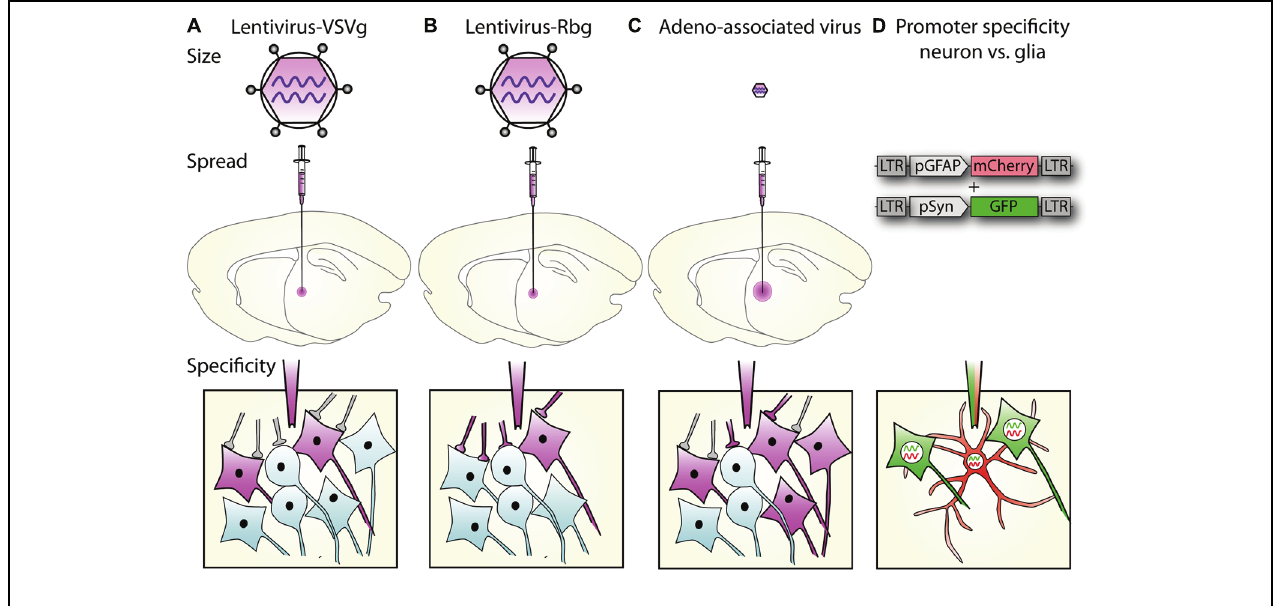
FIGURE 1 | Lentiviral vector spread, transduction, and expression is mediated by particle size, envelope properties and promoter usage. (A) Lentiviral vectors pseudotyped with vesicular stomatitis virus glycoprotein (VSVg) mediate local transduction with no retrograde or trans-synaptic viral transport. (B) In contrast, lentiviral vectors pseudotyped with a rabies glycoprotein (Rbg) transduce both the soma of local neurons and also afferents to the area. (C) AAV, depending on serotype, mediates larger physical spread,